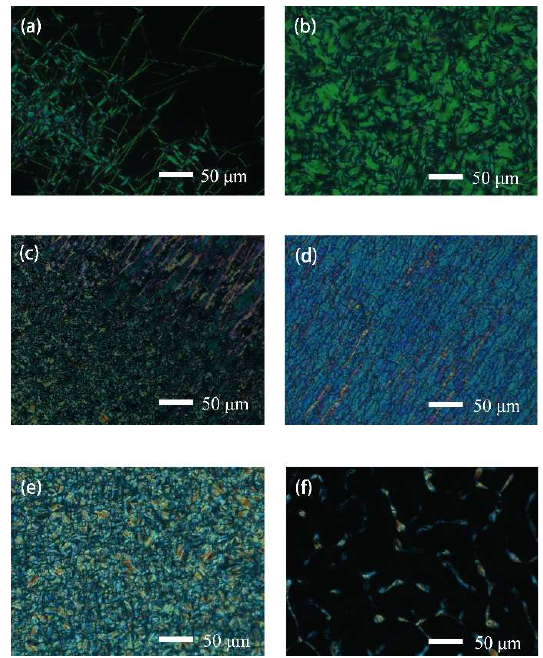
Figure 2. Typical polarized optical microscopic images of NB1GJ1 at different temperatures heated from glass states: ( a ) 21.2 °C, ( b ) 25.0 °C, ( c ) 29.2 °C, ( d ) 36.5 °C, ( e ) 58.4 °C, and ( f ) 58.6 °C.